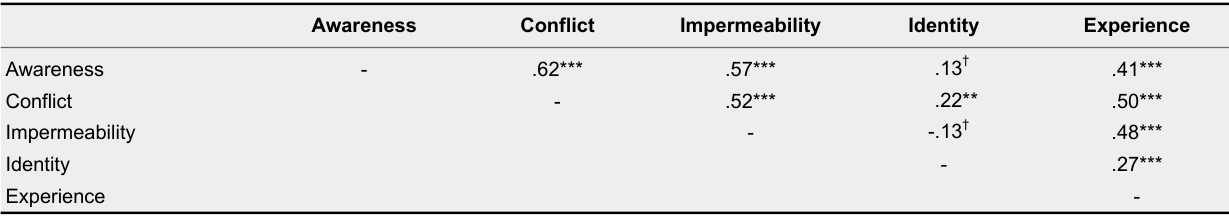
Latent Correlations Between the Five Class Consciousness Factors in the Parceled Measurement Model